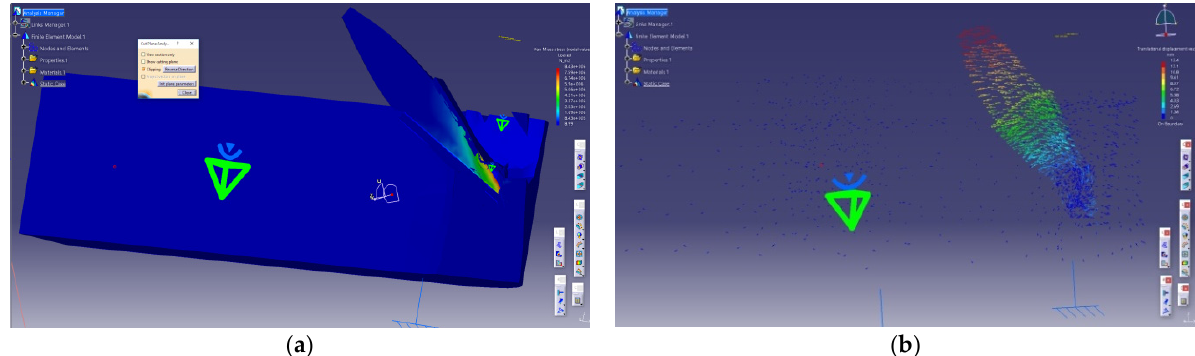
Figure 6. Lingualization of the lower LCI using a 3 N force: ( a ) von Mises tensions, 33% HBL; ( b ) tooth movement, 33% HBL.